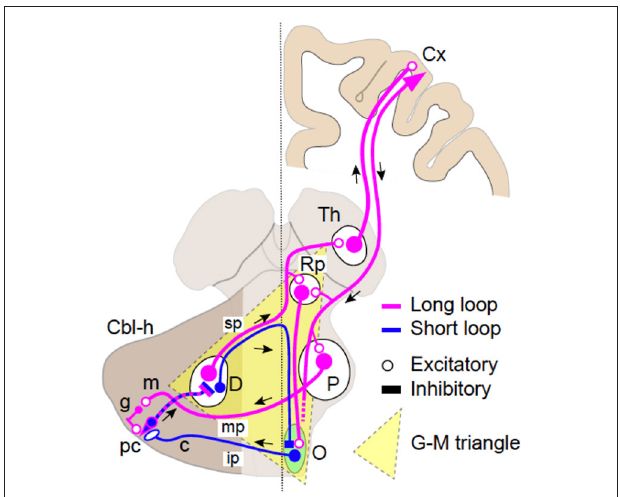
FIGURE 1 | Schematics of the two loop circuits in the Guillain–Mollaret triangle. The dentato-olivo-cerebellar loop (short loop, blue) and the cerebrocerebellar loop (long loop, magenta). Smaller GABAergic (inhibitory) cells in the dentate nucleus (D) pass through the superior cerebellar peduncle (SCP) (sp), cross the midline, and project directly to the contralateral inferior olivary nucleus (O). Efferent fibers from IO pass through the inferior cerebellar peduncle (ip) and project to Purkinje cells (PC, pc) in the contralateral cerebellar hemisphere (Cbl-h). PCs then project to DN cells to close the loop. The long loop is almost identical to the cerebrocerebellar loop. Larger excitatory DN cells pass through (SCP, sp), cross the midline, and project to the contralateral parvocellular red nucleus (RNp), and the thalamus (Th) with collaterals. Thalamocortical neurons relay the cerebellar inputs to various cortical areas (Cx). The return path to the cerebellum is the cortico-ponto-cerebellar tract, which originates from a various parts of the cerebral cortex. The corticofugal axons project directly to the PN (P) and finally arrive at the contralateral cerebellar hemisphere (Cbl-h) as mossy fibers (MFs) via the middle cerebellar peduncle (mp) to close the